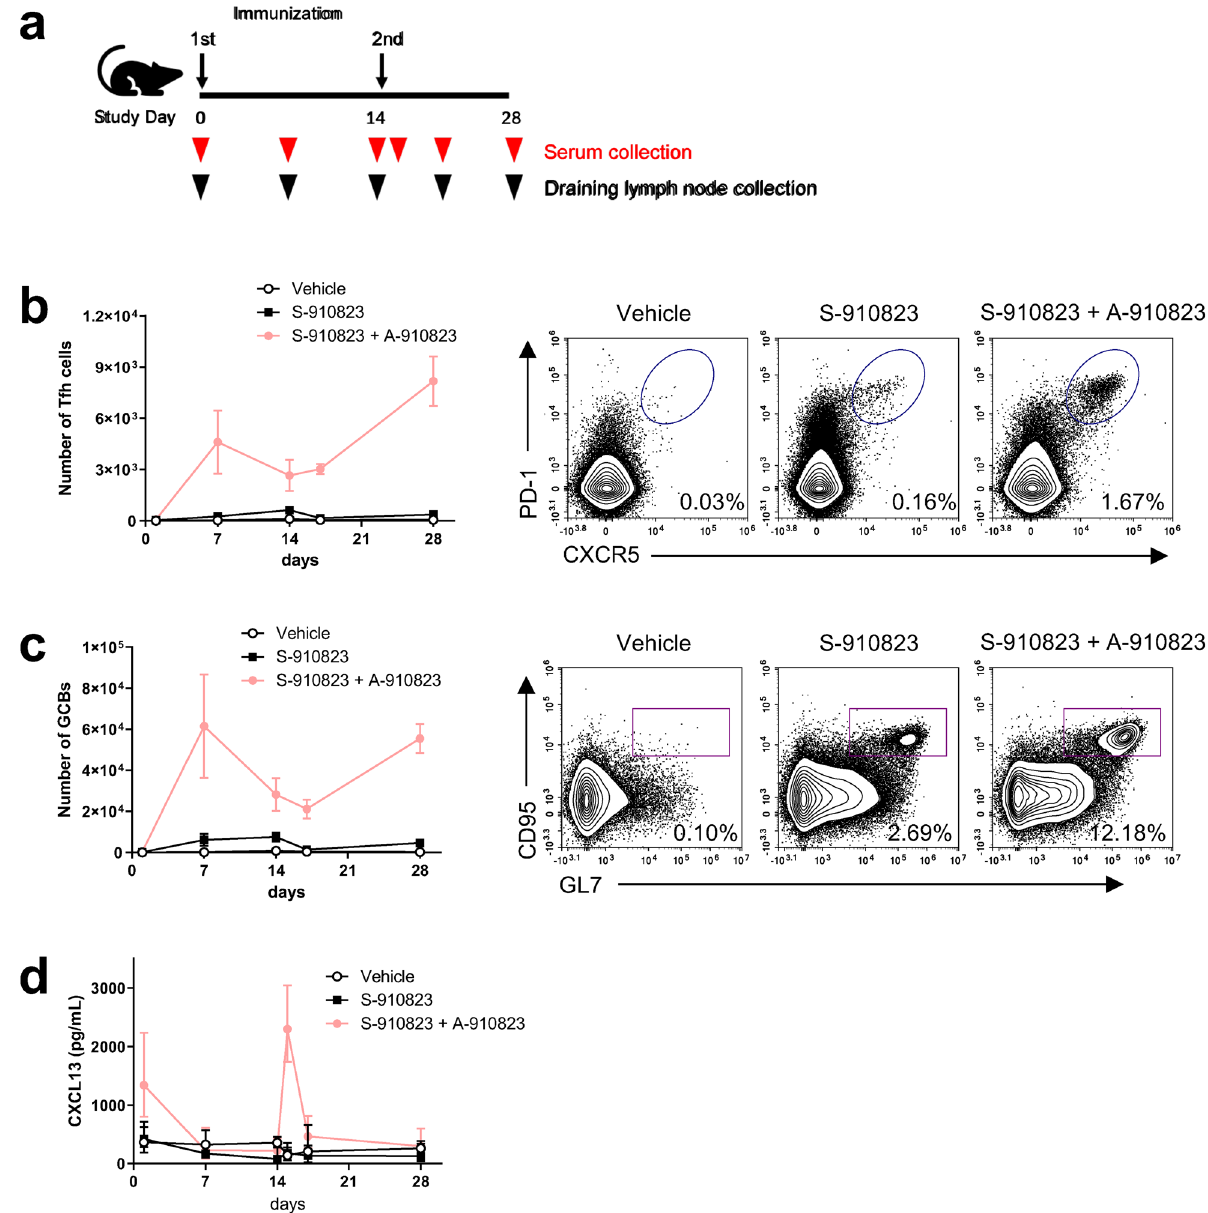
Figure 5. Generation of follicular helper T (Tfh) cells and germinal center B-cells (GCBs) in the draining lymph node of mice administered S-910823 plus A-910823. ( a ) Study schedule schematic. Mice were intramuscularly administered 1 μg of S-910823 with or without A-910823 on Day 0 and Day 14. Draining lymph nodes were collected from the immunized animals (n = 5/group) on days 1, 7, 14, 17, and 28 post-first administration. Serum was prepared from the blood samples collected on days 1, 7, 14, 15, 17, and 28 post-first immunization. ( b ) The number of Tfh cells and a representative contour plot. ( c ) The number of GCBs and a representative contour plot. ( d ) Serum levels of CXCL13 in immunized animals. The graph points represent mean cell number values ( b , c ) or mean concentration values ( d ). The error bars represent standard error of mean ( b , c ) or 95% confidence intervals ( d